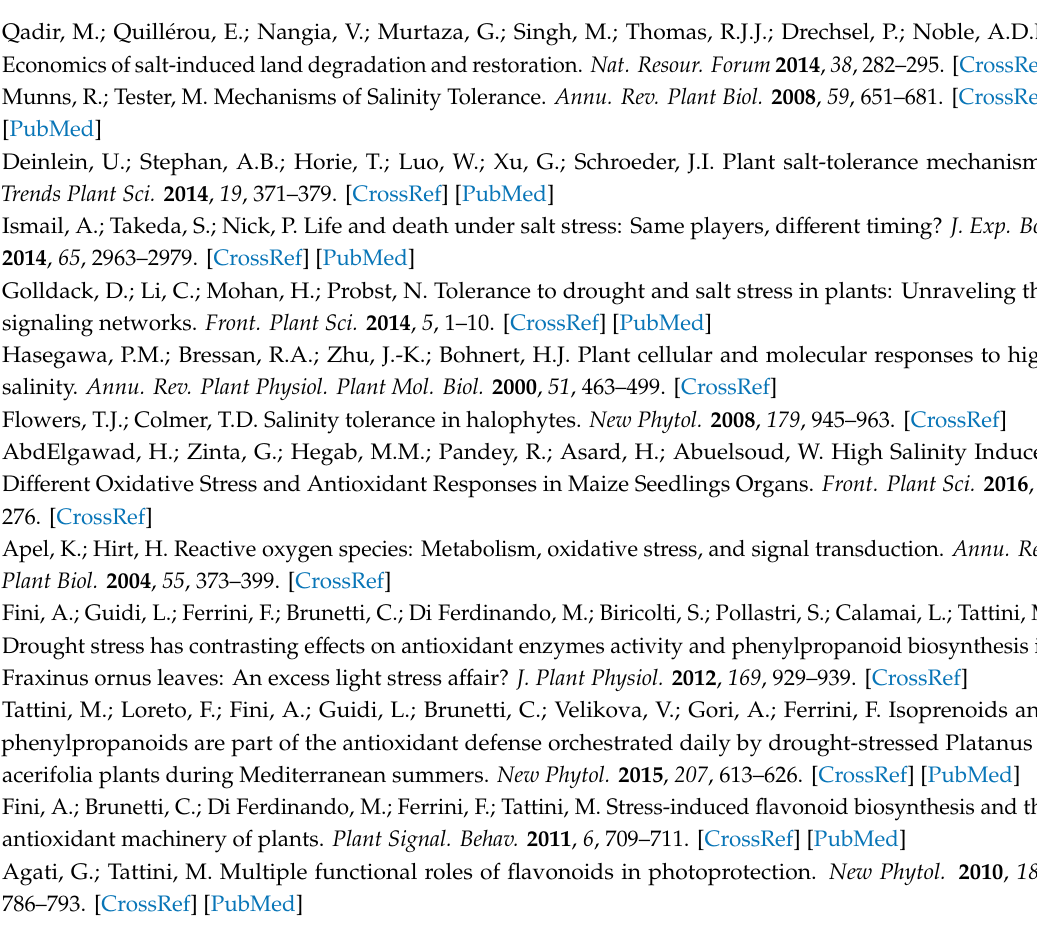
Table S1: List of primers used for qRT- PCR analysis in this study. Table S2: (-)-UHPLC-HRMS / MS data of compounds detected in cardoon leaves. Figure S1: Phenotype of “Bianco Avorio” and “Spagnolo” C. cardunculus var altilis genotypes at 21 days of hydroponic cultivation in 0 mM NaCl and 100 mM NaCl nutrient solutions, Figure S2: UHPLC-UV analysis of cynaropicrin accumulation in plants of the “Bianco Avorio” and “Spagnolo” C. cardunculus var altilis genotypes after 2 and 21 days of hydroponic cultivation in control (0 mM NaCl) and 100 mM NaCl nutrient solutions. Each value represents the mean ± SD of three biological replicates. Di ff erent superscript letters indicate significant di ff erences between genotypes and treatments within each sampling time, according to one way ANOVA ( p <